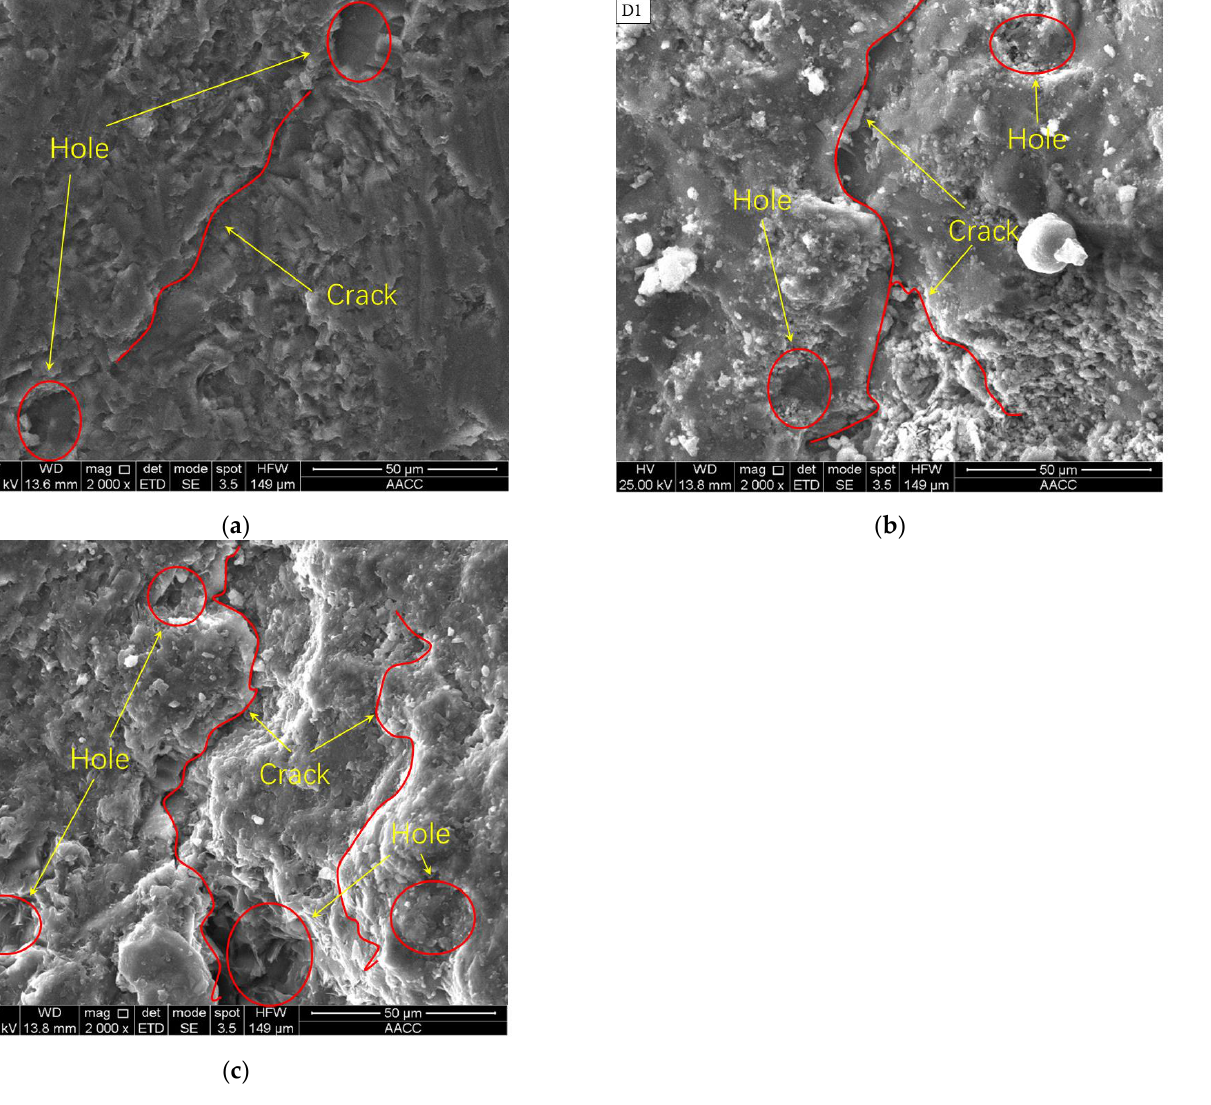
Figure 12. Mesoscopic fracture morphology of the samples under different moisture content according to SEM (2000×): ( a ) dry specimen; ( b ) specimen with 0.62% moisture content; ( c ) saturated specimen.